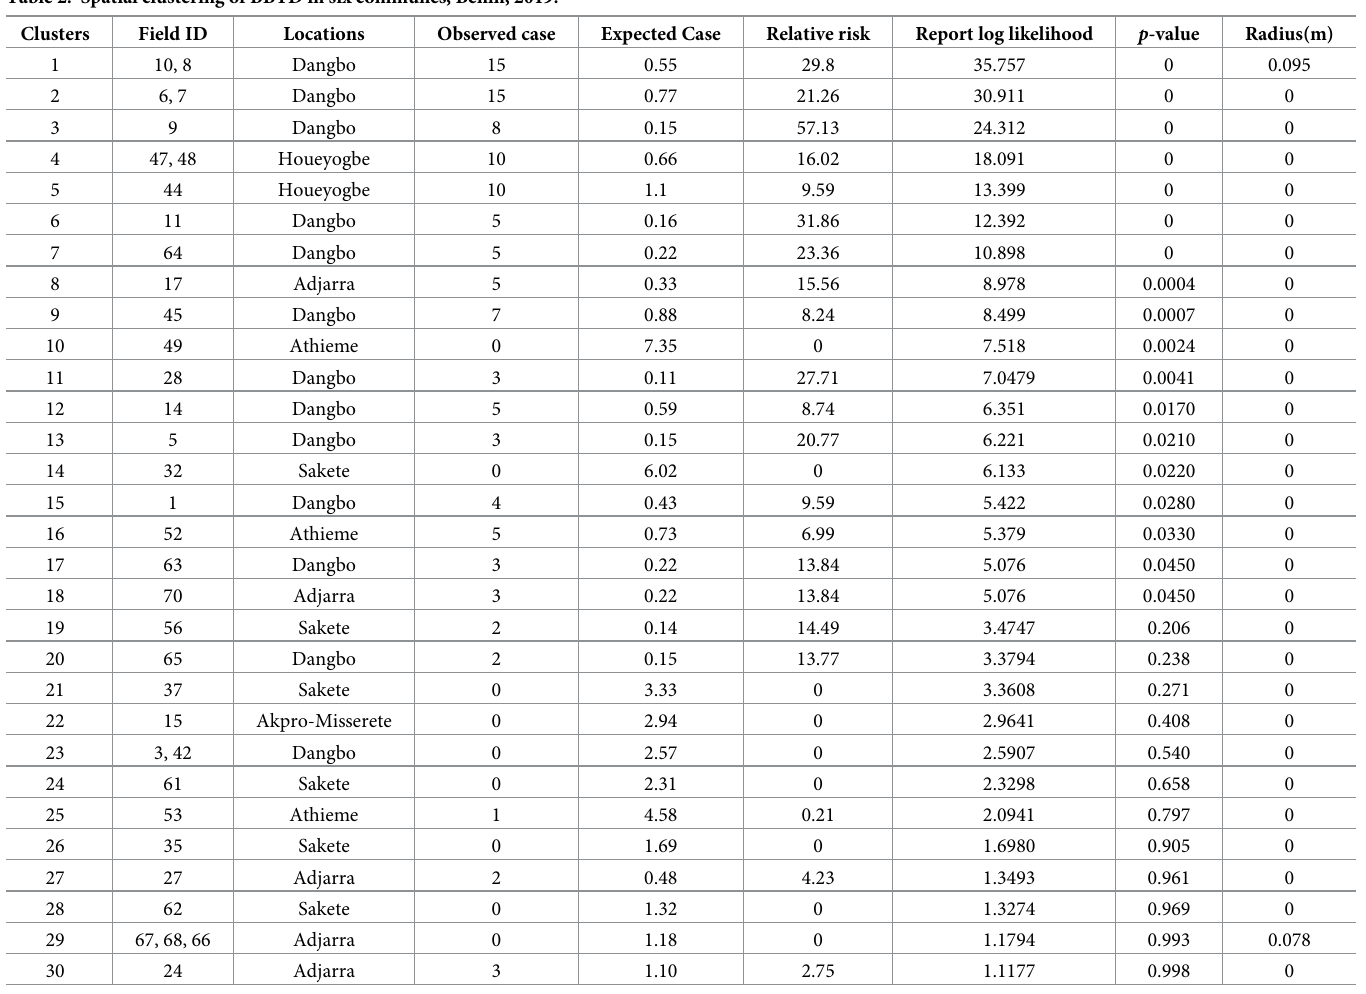
Table 2. Spatial clustering of BBTD in six communes, Benin,